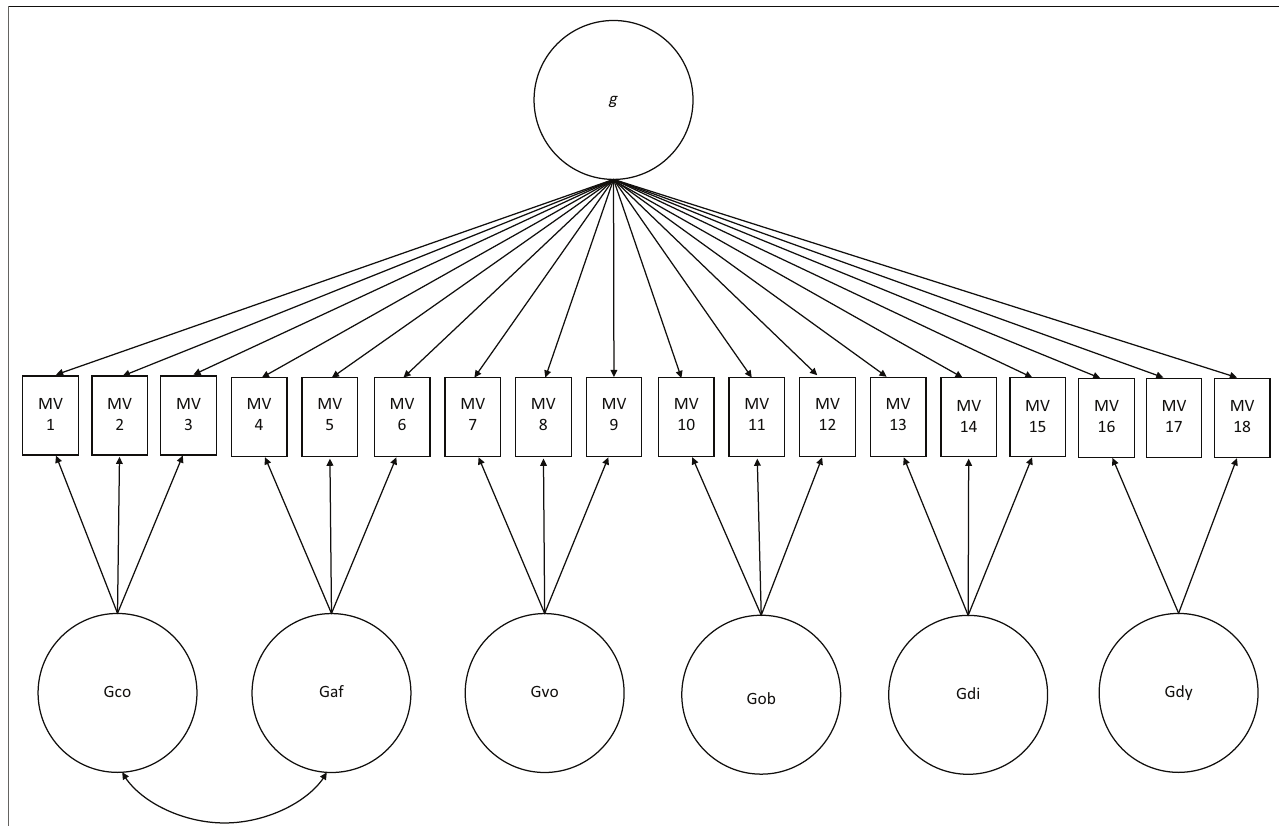
FIGURE 2: Bifactor model of goal